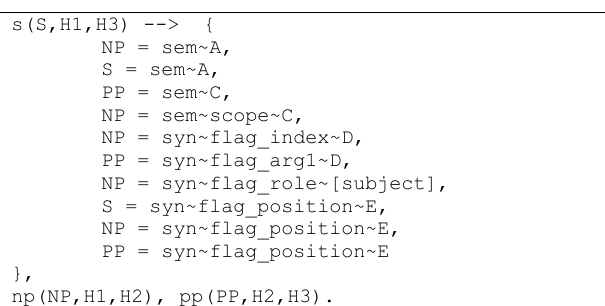
Figure 3. Analyze the sentence with the second structure based on framework GULP (Source: T. Tran and D. T. Nguyen [28])